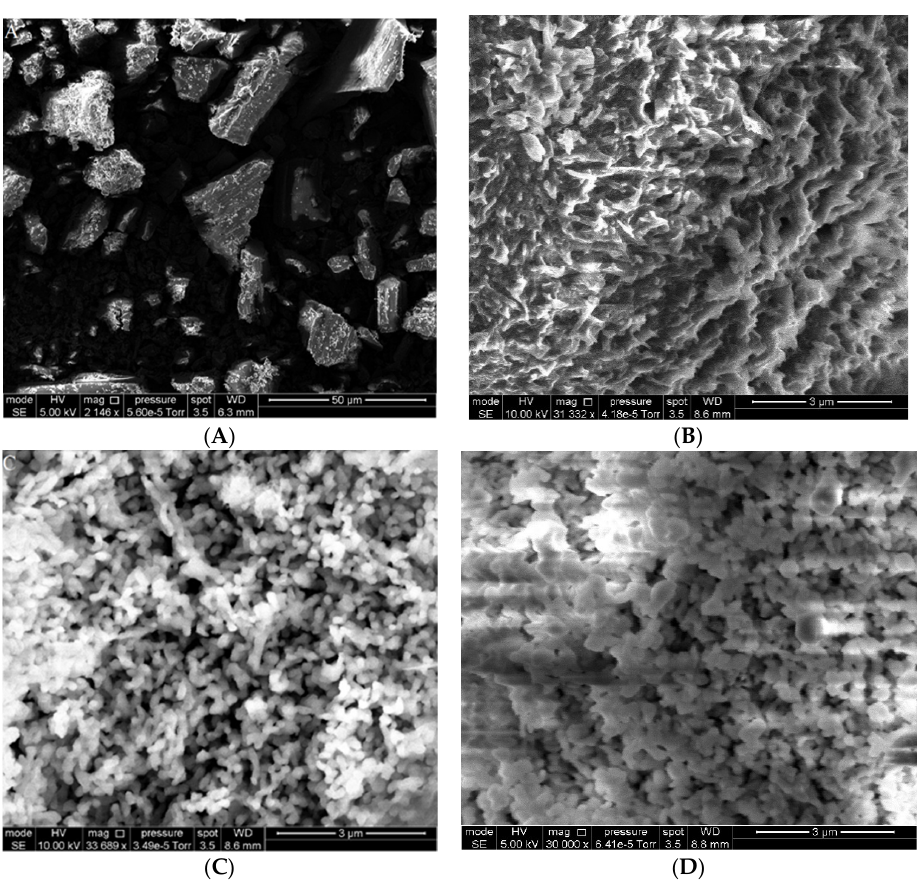
Figure 1. SEM images of the pharmacopoeia dioxidine ( A ) and of the cryomodified dioxidine samples obtained in the absence of a gas carrier (CO 2 ) flow ( B ), with a gas carrier (CO 2 ) flow of 7.0 × 10 16 molecules s − 1 cm − 2 ( C ), with a carrier gas (CO 2 ) flow of 7.0 × 10 17 molecules s − 1 cm − 2 ( D ).